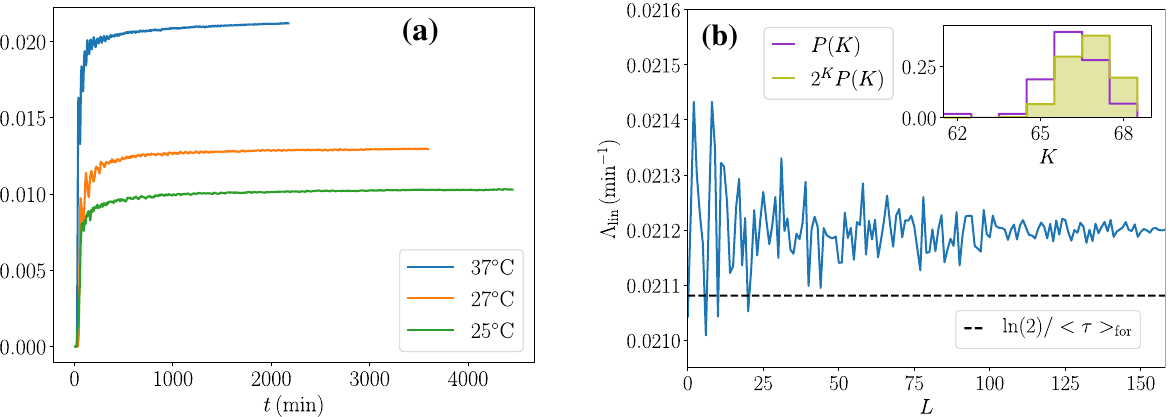
Figure 2. Estimator of the population growth rate (cid:31) lin based on Eq. (5), ( a ) as function of the the length t of the lineages and ( b ) as function of the number L of lineages used in the estimation. In ( a ), the curves for the three temperatures converge to a constant value. In ( b ), only the curve for 37 °C is shown and the horizontal dashed line represents the quantity ln ( 2 )/ (cid:31) τ (cid:30) for , which is smaller than the limit value of (cid:31) lin , as expected from the second law-like inequality, namely Eq. (15). In the inset, the purple histogram is the distribution of the number of divisions, while the green filled histogram is the histogram deduced from it by weighting it by a factor 2 normalizing. All the 160 lineages were used to plot these